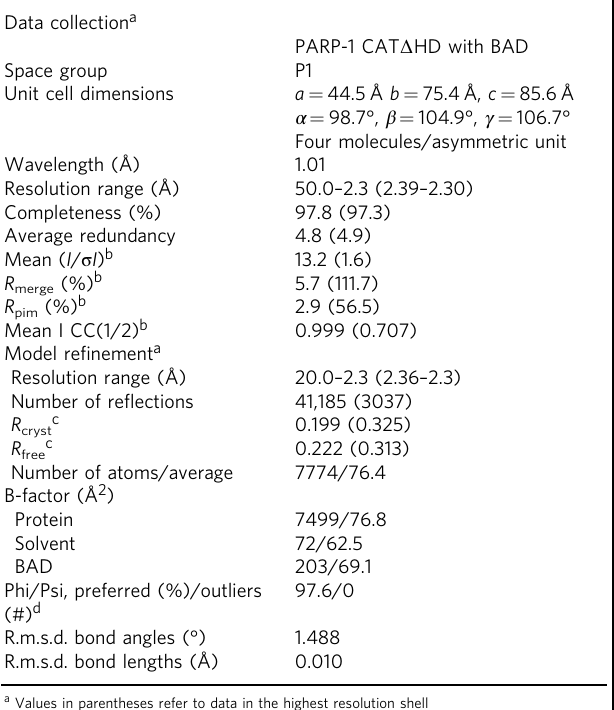
PARP-1 CAT Δ HD with BAD